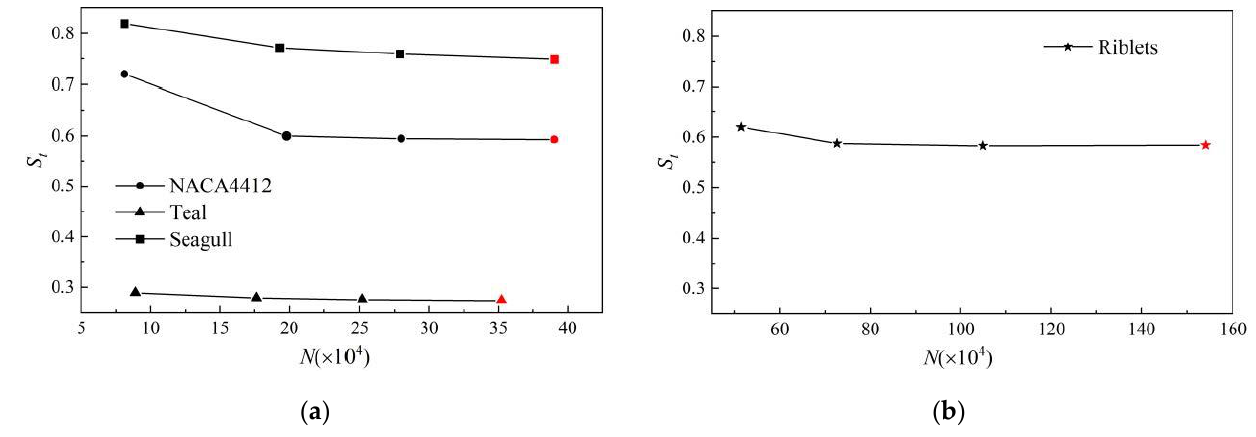
Figure 3. Grid independence verification. ( a ) NACA4412, Teal and Seagull, ( b ) Riblets.